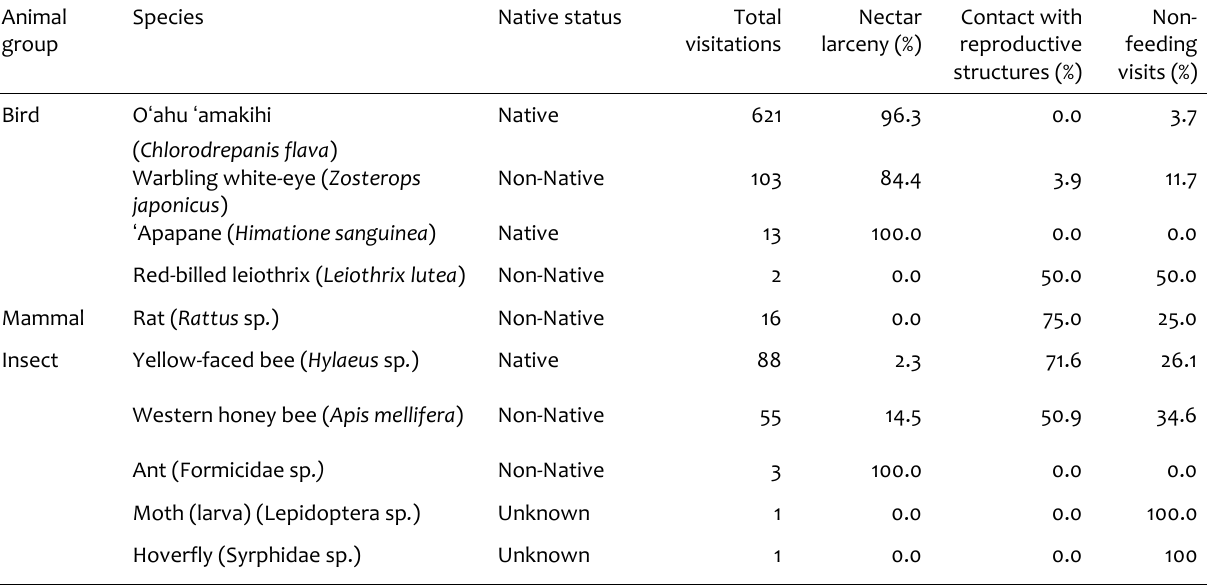
Floral visitation by each species and percent of feeding visits (nectar larceny or contact with reproductive structures) or non-feeding visits, which includes visits where animals made physical contact with flowers but did not take nectar nor make contact with reproductive